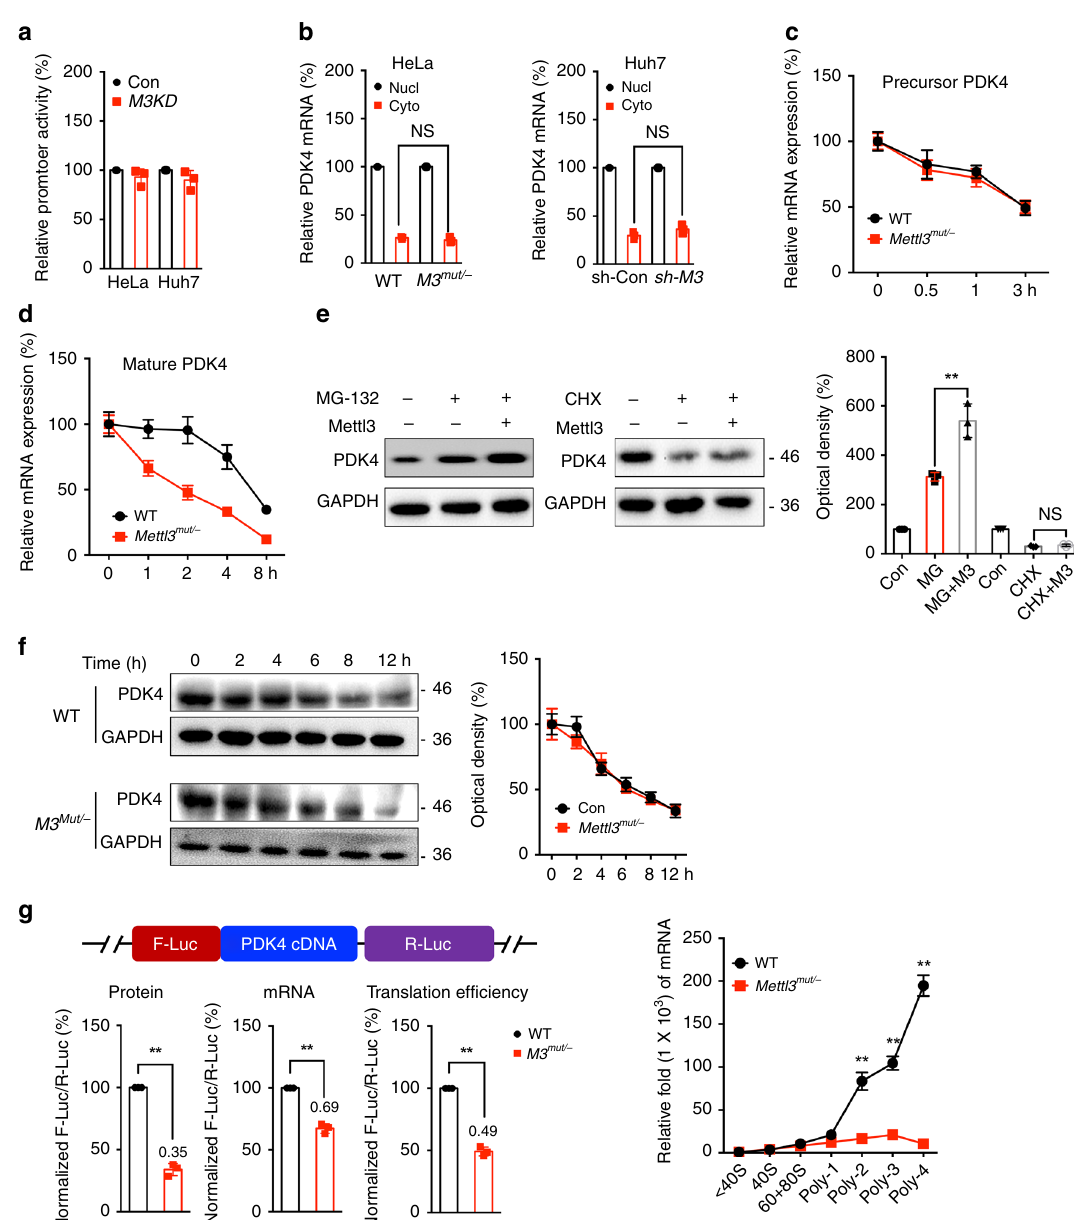
Fig. 3 m 6 A regulates the mRNA stability and translation of PDK4 in cancer cells. a Cells were transfected with pGL3-Basic-PDK4-luc reporter and pRL- TK plasmid for 24 h. Results were presented as the ratios between the activity of the reporter plasmid and pRL-TK. b The relative levels of nuclear versus cytoplasmic PDK4 mRNA in wild-type and Mettl3 Mut/- cells, or sh-control and sh- Mettl3 Huh7 cells. c After treatment with Act-D to inhibit transcription, the precursor mRNA levels of PDK4 were checked in wild type and Mettl3 Mut/- cells. d After treatment with Act-D for the indicated times, the mature mRNA levels of PDK4 were checked in wild type and Mettl3 Mut/- cells. e HeLa cells were pre-transfected with vector control or Mettl3 construct for 24 h and then further treated with CHX (10 μ g/ml) or MG-132 (5 μ M) for 6 h, the expression of PDK4 was detected by western blot analysis (left) and quantitatively analyzed (right). f Cells were treated with 10 μ g/ml CHX for the indicated time periods, the expression of PDK4 was detected by western blot analysis (left) and quantitatively analyzed (right). g Wild-type or Mettl3 Mut/- HeLa cells were transfected with pmirGLO-PDK4 reporter for 24 h. The translation outcome was determined as a relative signal of F-luc divided by R-luc, the mRNA abundance was determined by qRT-PCR of F-luc and R-luc, and the translation ef fi ciency of PDK4 is de fi ned as the quotient of reporter protein production (F-luc/R-luc) divided by mRNA abundance 28 . h qRT-PCR checked the mRNA levels of PDK4 in non-ribosome portion (<40S), 40S, 60S, 80S, and polysome fractions in wide type and Mettl3 Mut/- HeLa cells. Data are presented as the mean ± SD from three independent experiments. * p < 0.05, ** p < 0.01, NS, no signi fi cant, by two-tailed unpaired Student ’ s t test for ( a ) and ( c ) ( p < 0.0001 for all comparisons), and two-way ANOVA for ( b ) ( p > 0.05), and by one-way ANOVA for ( e ) ( p = 0.005) and ( h ) ( p < 0.0001 for all